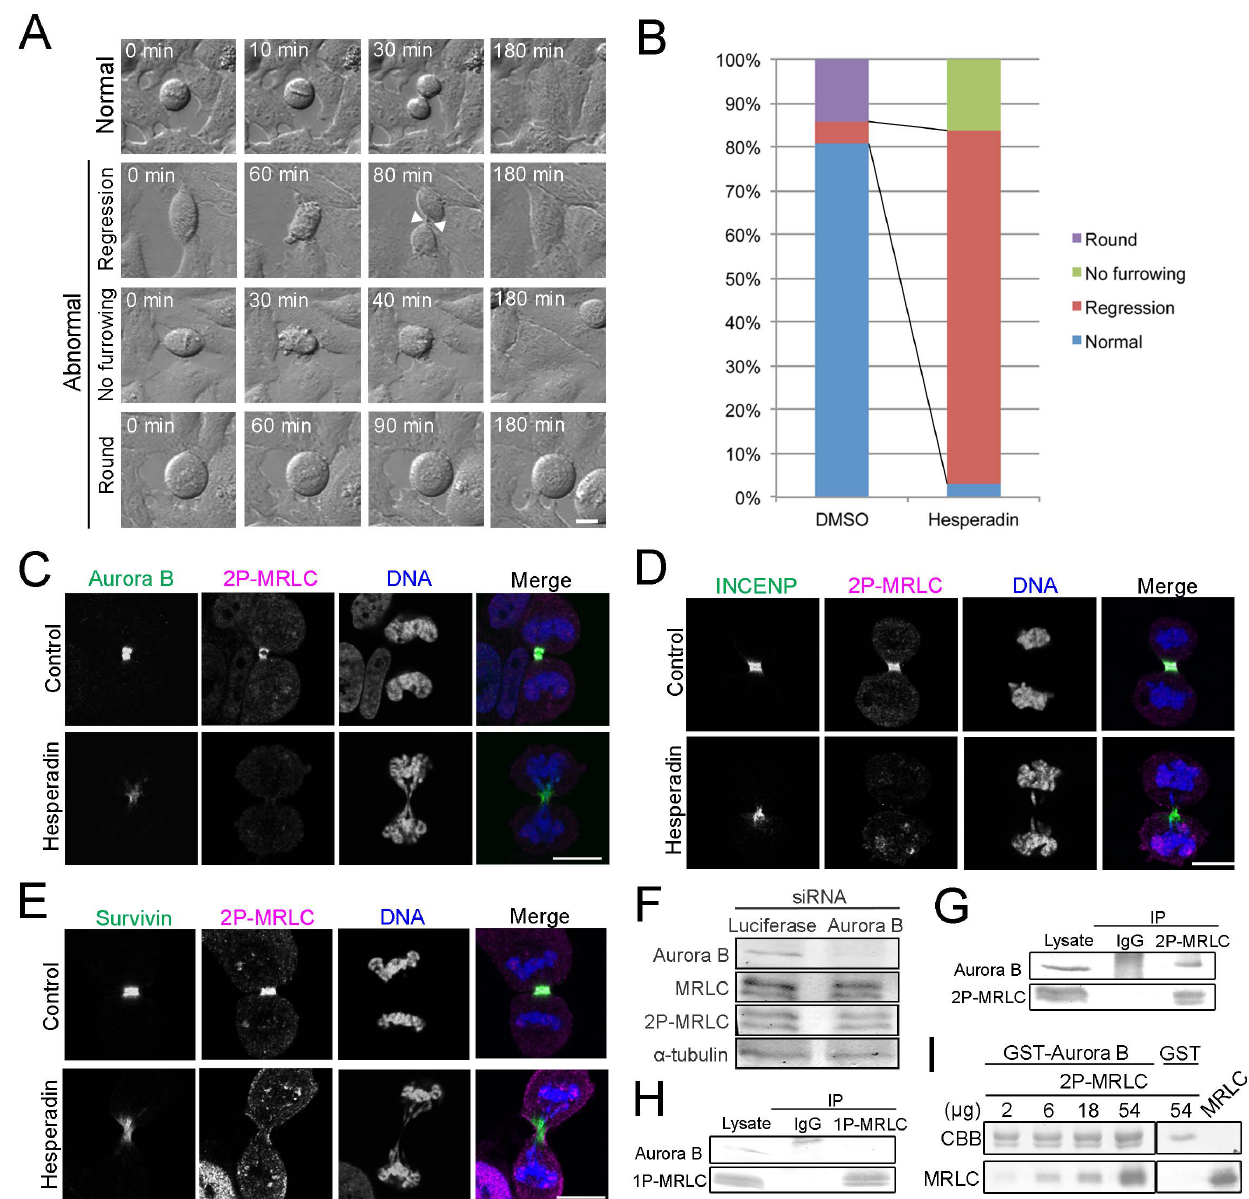
Figure 4. Aurora B activity, but not INCENP or survivin, is crucial for the localization of 2P-MRLC at the midbody. (A) Representative time-lapse imaging of HeLa cells treated with DMSO or 0.1 m M hesperadin for 3 h. Normal: a dividing cell; Regression: a furrow ingression (white arrowheads) but not in cells undergoing abscission; No furrowing: a cell showing no furrow ingression and no abscission; Round: a cell appearing round for at least 3 h. Bar, 10 m m. (B) Quantitative analysis of cells like those shown in (A). n $ 63. (C–E) HeLa cells treated with DMSO or 0.1 m M hesperadin for 30 min were fixed and immunostained as indicated. (F) Western blot detection of total MRLC and 2P-MRLC in mitotic HeLa cells treated with siRNA targeting luciferase or Aurora B. (G) Western blot detection of Aurora B in immunoprecipitates of endogenous 2P-MRLC from mitotic HeLa cell lysates. Endogenous 2P-MRLC was immunoprecipitated by 4F12. IP, immunoprecipitates; IgG, normal mouse IgG for a negative control. (H) Western blot detection of Aurora B in immunoprecipitates of endogenous 1P-MRLC from mitotic HeLa cell lysates. Endogenous 1P-MRLC was immunoprecipitated by CS1P mAb. IP, immunoprecipitates; IgG, normal mouse IgG for a negative control. (I) GST-Aurora B and GST were incubated with 2, 6, 18, or 54 m g 2P-MRLC. The upper panel indicates GST-Aurora B (66 kDa) or GST (26 kDa) on a Coomassie Brilliant Blue (CBB)- stained membrane, and the bottom panel shows MRLC detected by western blotting.